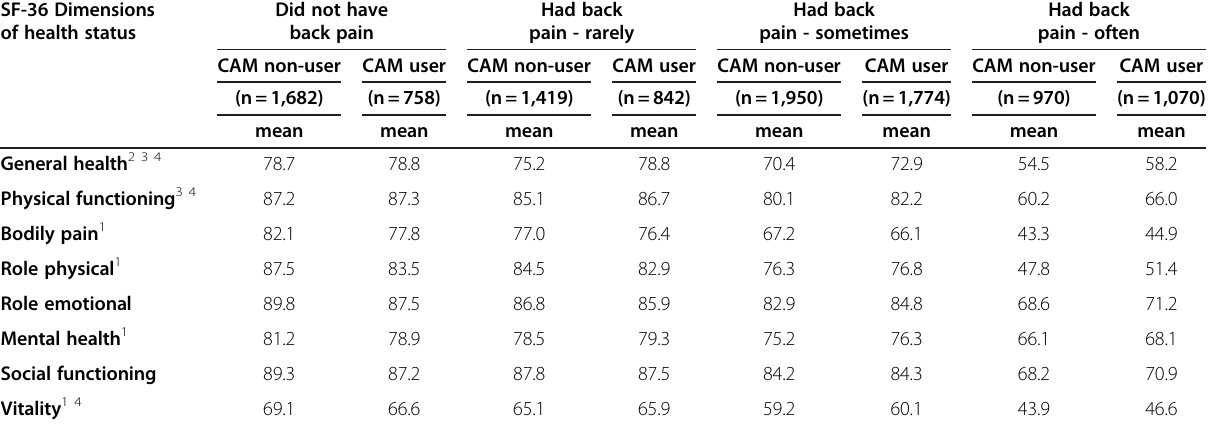
Table 5 Back pain status and SF-36 dimensions of health status by CAM user status (consulted with a CAM practitioner or